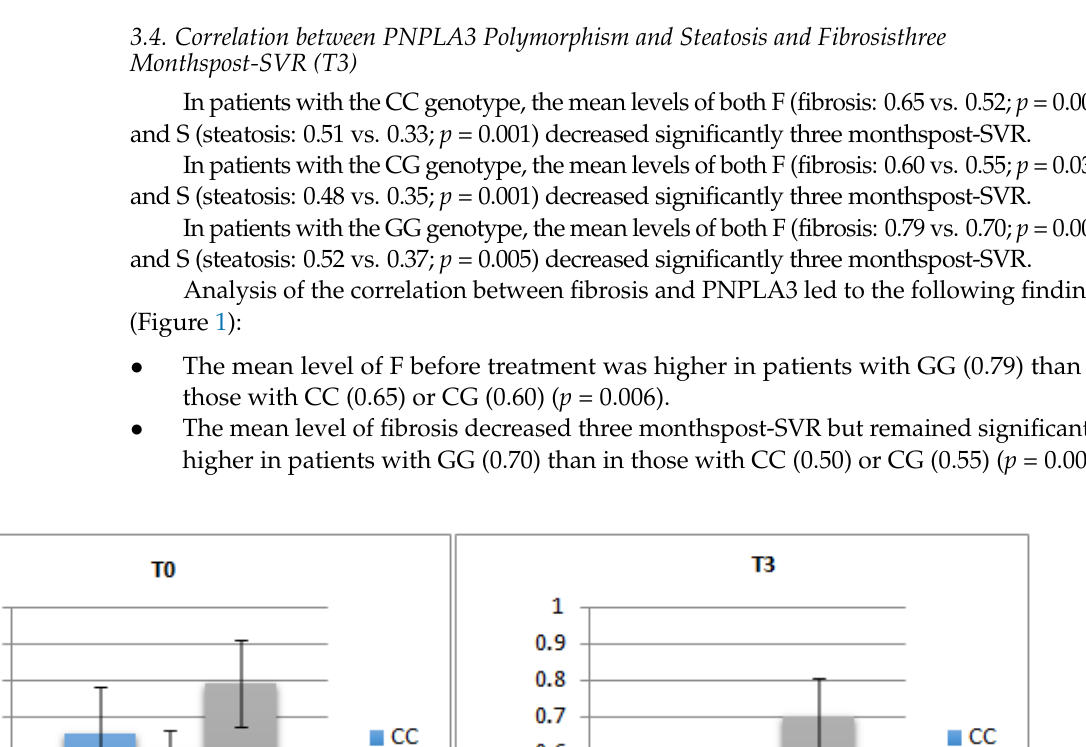
F — fibrosis; S — steatosis.